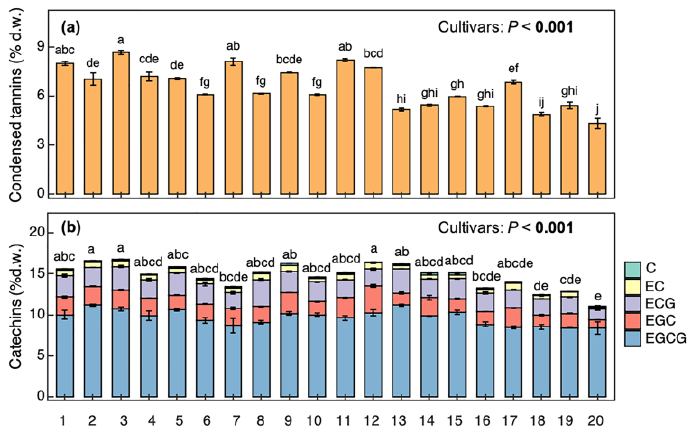
Figure 2. Variations in concentrations of main phenolic compounds within tea leaves across 20 tea cultivars. ( a ) Condensed tannins; ( b ) Catechins ( Σ C, EC, ECG, EGC, EGCG). Each bar represents the mean value ± SE (n = 3 plot replicates). % d.w. = % foliar dry weight. C, catechin; EC, epicatechin; ECG, epicatechin gallate; EGC, epigallocatechin; EGCG, epigallocatechin gallate. Different lowercase letters indicate significant differences among cultivars ( p < 0.05).